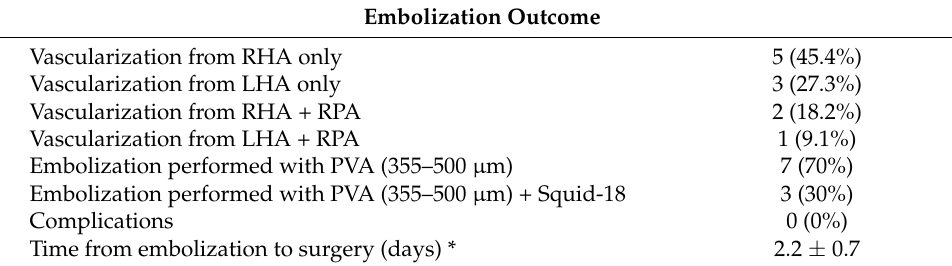
Table 2. Embolization